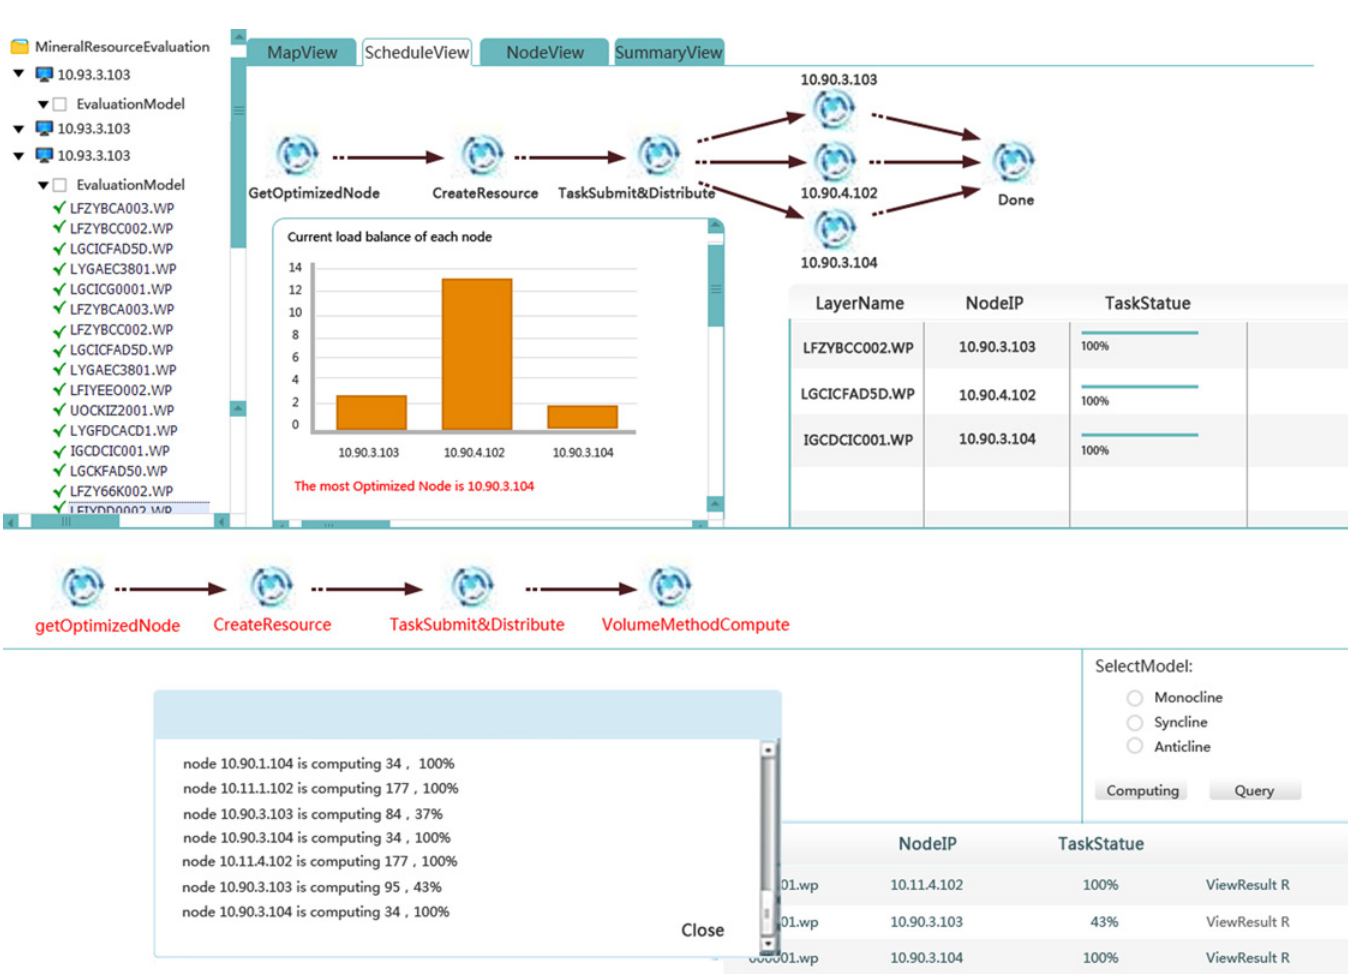
Fig 17. Iron mine potential evaluation workflow.